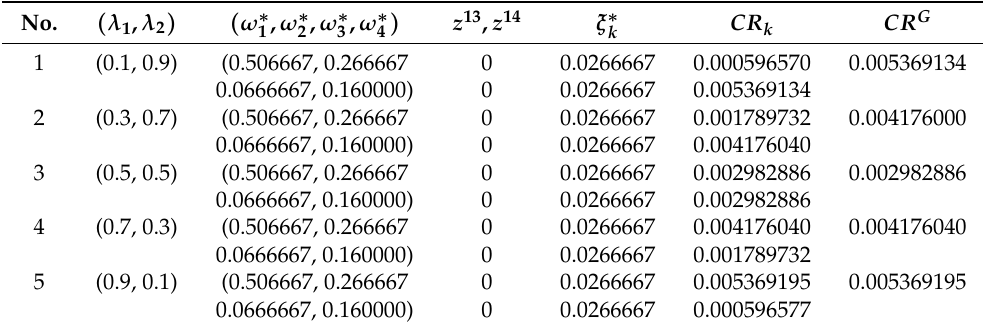
Table 5. Result of Example 1 solving with MD-1.